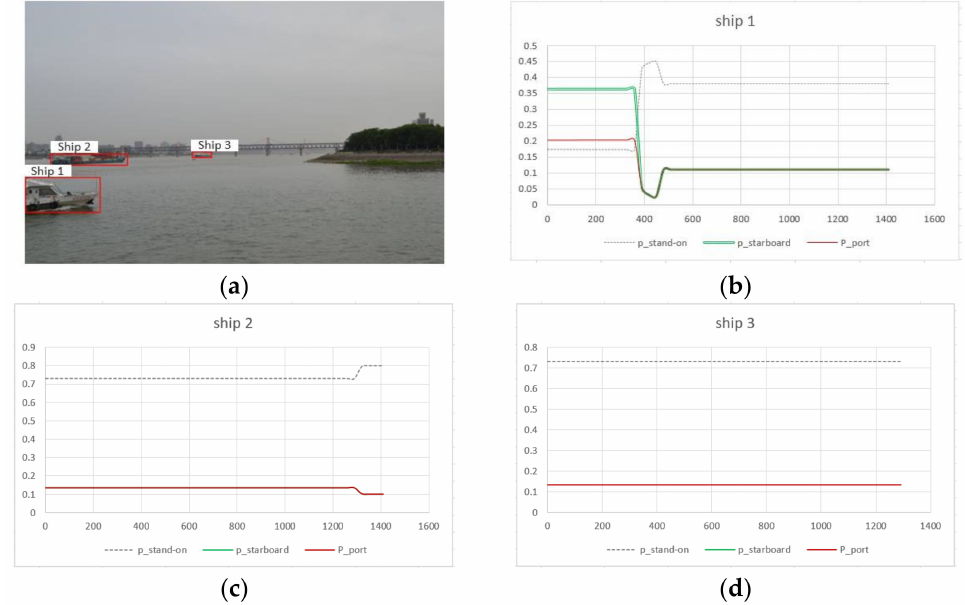
Figure 14. Prediction results of ship navigational intention in typical scenarios of intersection channel. ( a ) Ships detection results. ( b ) Intention identification probability of Ship 1. ( c ) Intention identification probability of Ship 2. ( d ) Intention identification probability of Ship 3.